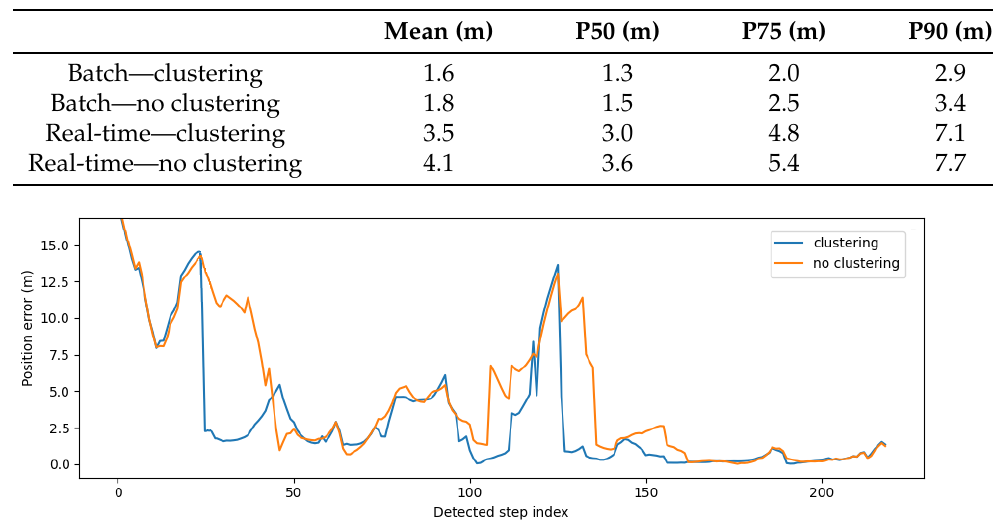
Figure 11. Real-time position error with (blue) and without (orange) the proposed clustering al- gorithm on top of the (backtracking) particle filter as a function of the detected step index, for Trajectory